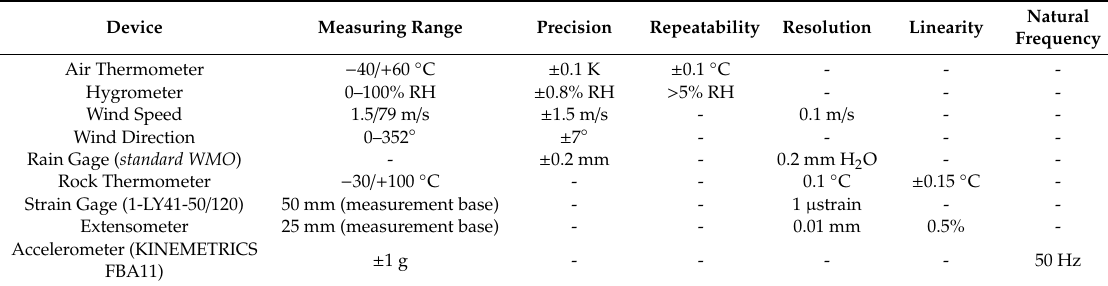
Table 2. Technical features of the installed devices.